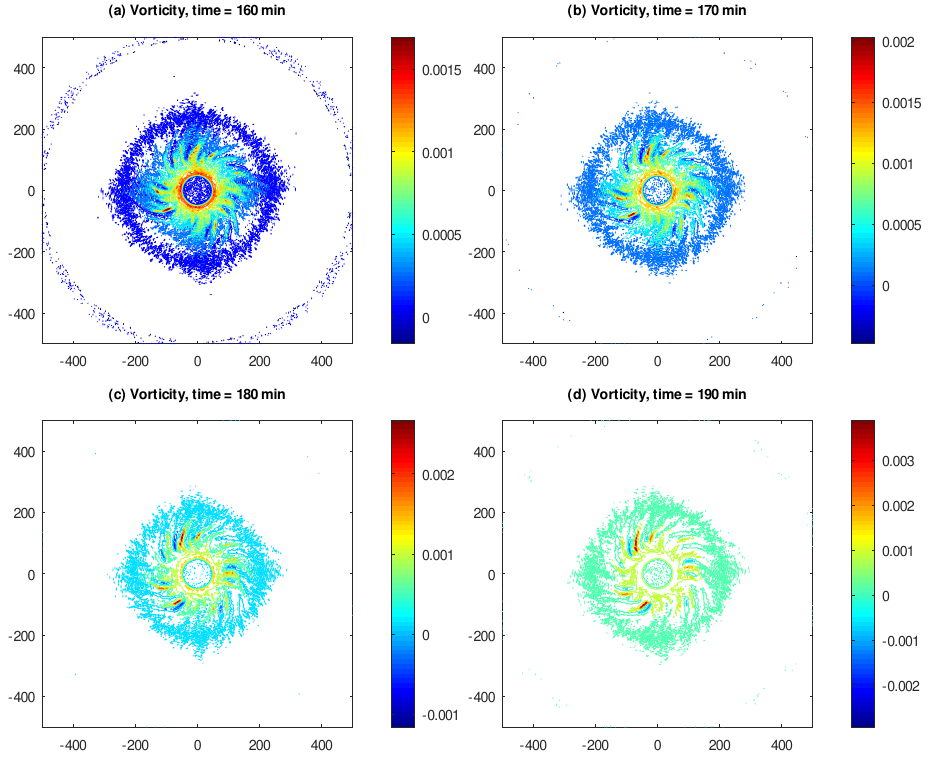
Figure 6. Vorticity of the cyclostrophic flow, expressed in s − 1 , and captured at ( a ) 160, ( b ) 170, ( c ) 180 and ( d ) 190 min of elapsed model time. The domain size is 1000 × 1000